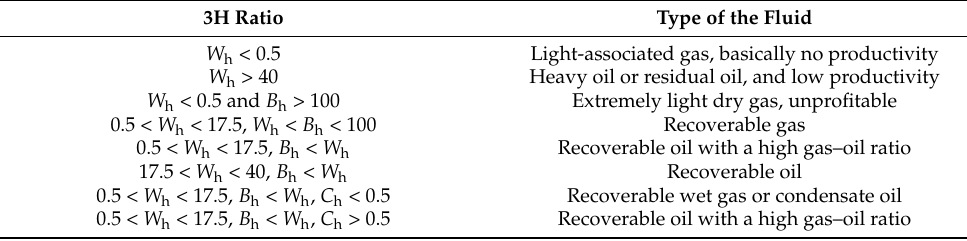
Table 3. 3H ratio method judgment